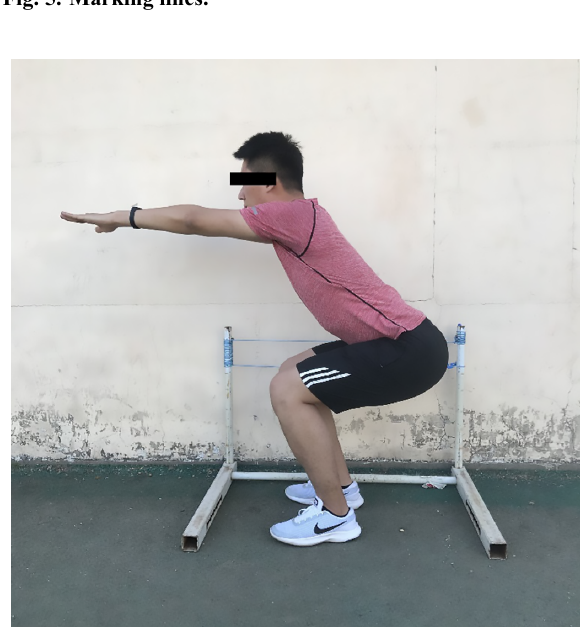
Fig. 5. Marking lines.